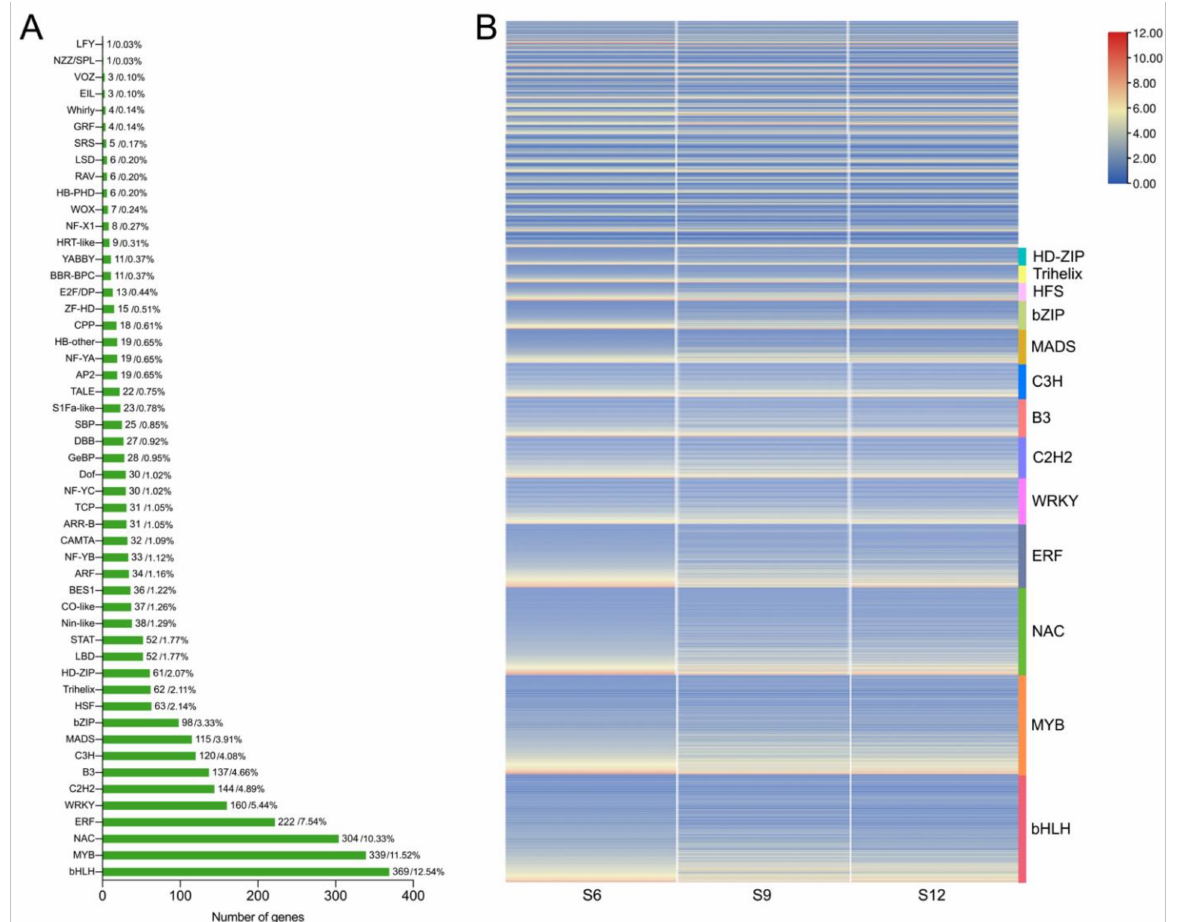
Figure 5. Analysis of transcription factors in different developmental stages of sweet cherries. ( A ) Statistical summary of transcription factor families; the number and proportion of each transcrip- tion factor family are displayed in a bar chart; ( B ) heat map of transcription factor expression patterns. The FPKM values of transcription factors were transformed according to